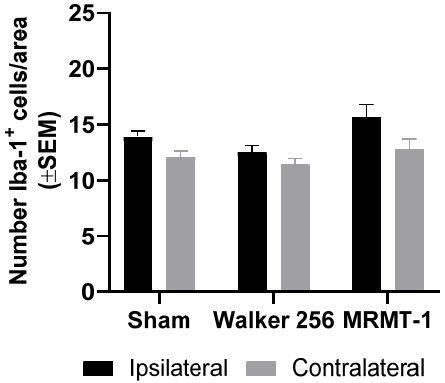
Figure 4. CIBP does not induced microglial reaction in two different CIBP rat models. Intratibial inoculation of MRMT-1 or Walker 256 carcinoma cells did not cause a significant upregulation of Iba-1 + cells in the ipsilateral dorsal horn of the spinal cord of cancer-bearing rats compared with sham. Sham n = 10; Walker 256 n = 7; MRMT-1 n = 6. Data are presented as mean ± SEM.